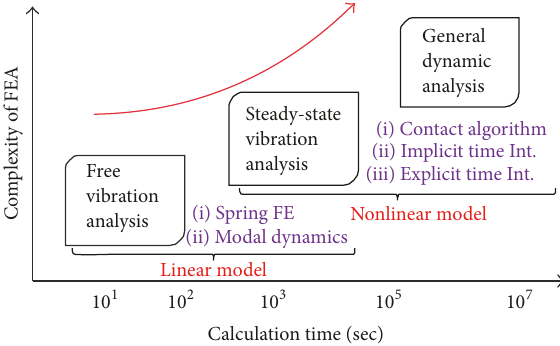
Figure 1: Workflow followed in this